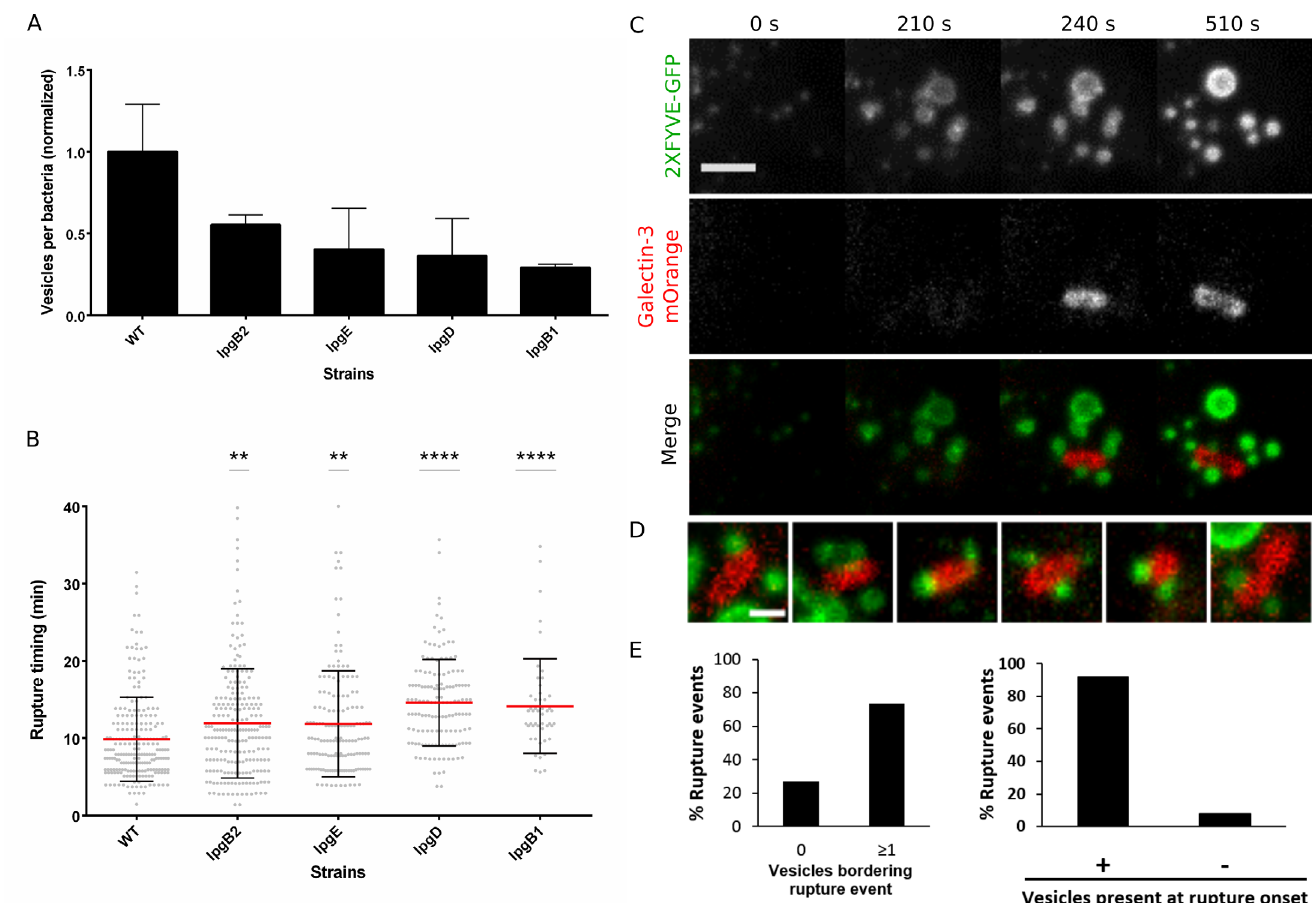
Fig 3. Macropinosome availability is correlated with the efficiency of vacuolar rupture and macropinosomes border the BCV at the onset of vacuolar rupture. (A) Effector mutant library macropinosome formation screen. Number of macropinosome per bacteria at the invasion site was quantified for infection with WT and various effector mutant strains (n (cid:1) 70 invasion sites per strain from 2 independent experiments). (B) Effector mutant library vacuolar rupture timing screen (n (cid:1) 50 invasion events per strain, from 3 independent experiments. Significance of mutant vs. WT was determined using one way ANOVA.). Each data point represents a single rupture event recorded during live imaging. (C) Confocal time-lapse microscopy of cells transfected with the PI3P macropinosome marker 2XFYVE-GFP and vacuolar rupture marker galectin-3-mOrange, and infected with WT bacteria. Typical events are presented: onset of membrane ruffling (0 s), formation of macropinosomes (210 s), vacuolar rupture in close proximity to macropinosomes (240 s), ongoing macropinosome presence and progression of rupture (510 s). Images were taken every 30 s, z-projections are presented, scale bar is 5 μ m. See also S3 Movie. (D) Gallery of different rupture events where macropinosomes (labeled by 2XFYVE-GFP) border rupturing BCVs (labeled by galectin-3-mOrange). Scale bar is 2 μ m. (E) Frequency of macropinosomes bordering (within 1 μ m) the rupturing BCV from total rupture events observed (left). In 73% of vacuolar rupture events analyzed macropinosomes were found bordering the BCV (n = 30 rupture events in 3 independent experiments). Frequency of vesicles present at rupture onset based on high temporal resolution imaging (right). Macropinosome were found at least one frame before rupture in 92% of rupture events containing bordering macropinosomes (n = 36 rupture events in eight independent